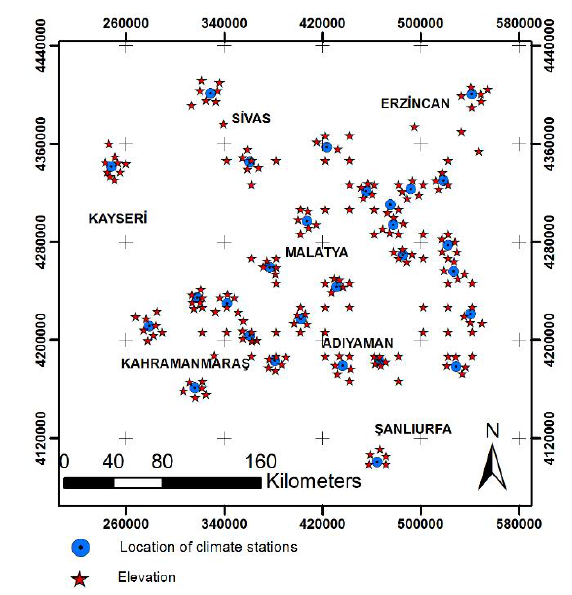
Figure 2. Spatial orientation of primary (mean monthly temperature) and auxiliary (elevation) values used in the ordinary cokriging